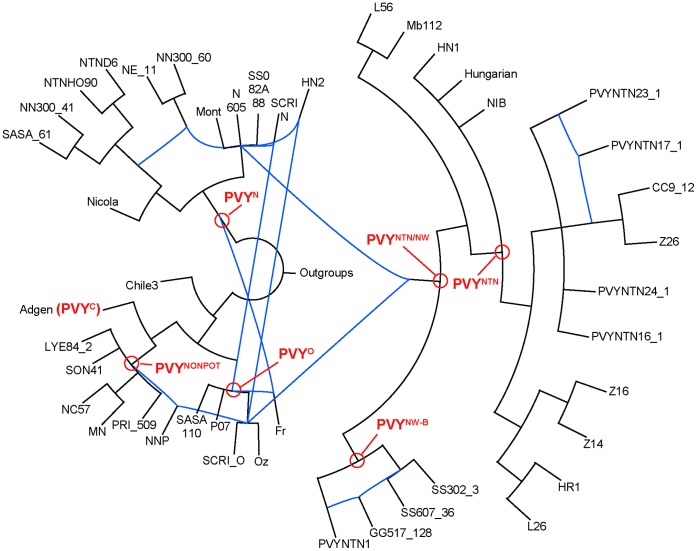
A reticulate phylogenetic hypothesis for PVY genomes.A rooted phylogenetic network, assuming that recombination (blue branches) represents reticulation events. The nodes representing the most recent common ancestors of PVY strains and recombinant clades are indicated with red circles and labels.